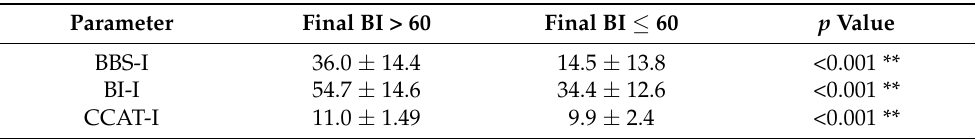
Table 3. The top three importance predictors in the random forest machine-learning model to pre-